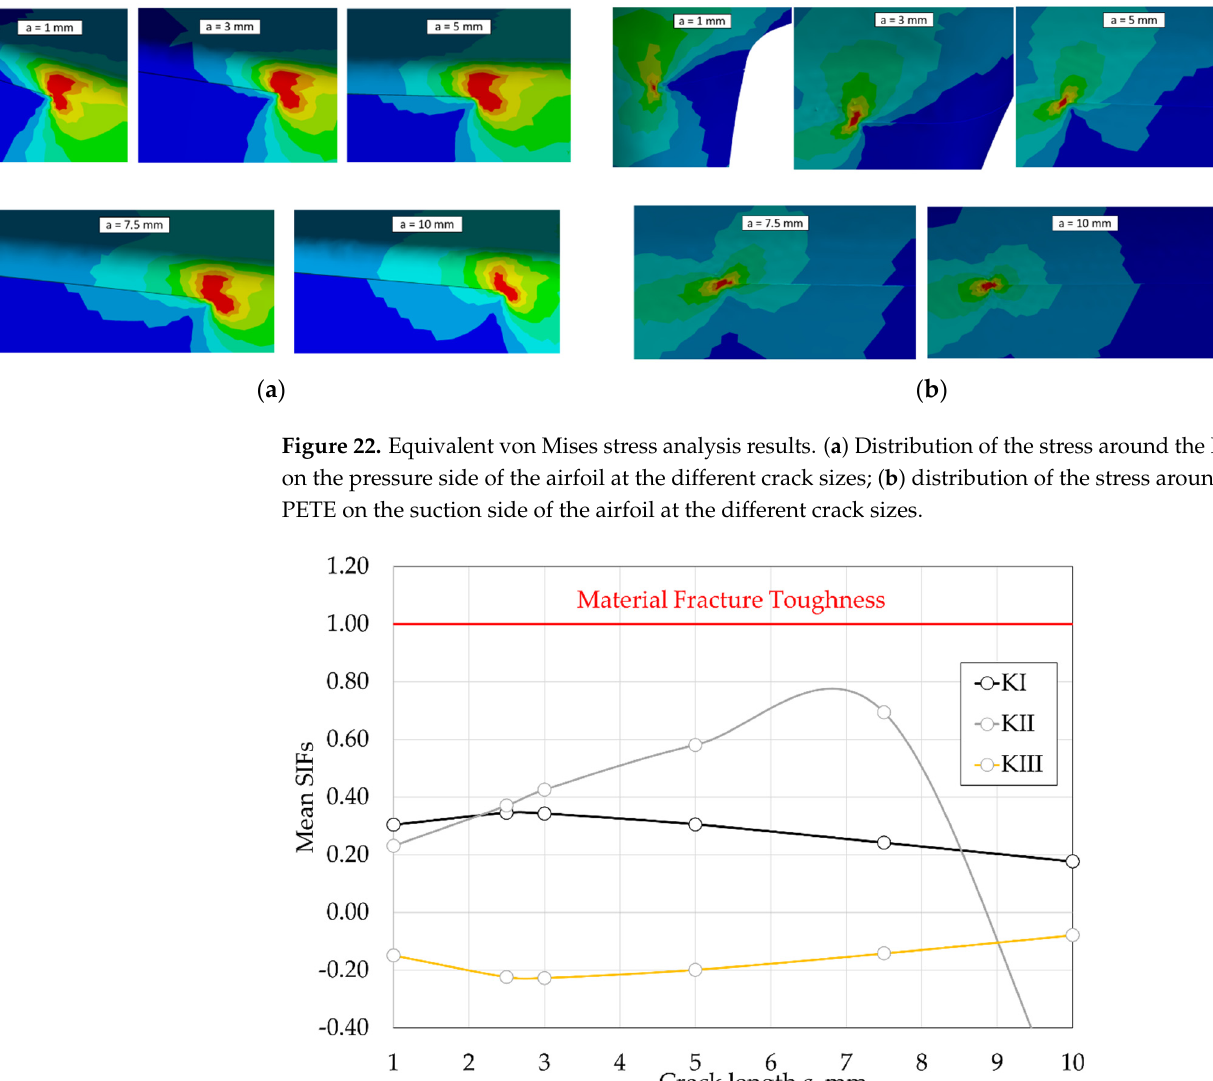
Figure 22. Equivalent von Mises stress analysis results. ( a ) Distribution of the stress around the PETE on the pressure side of the airfoil at the different crack sizes; ( b ) distribution of the stress around the PETE on the suction side of the airfoil at the different crack sizes.